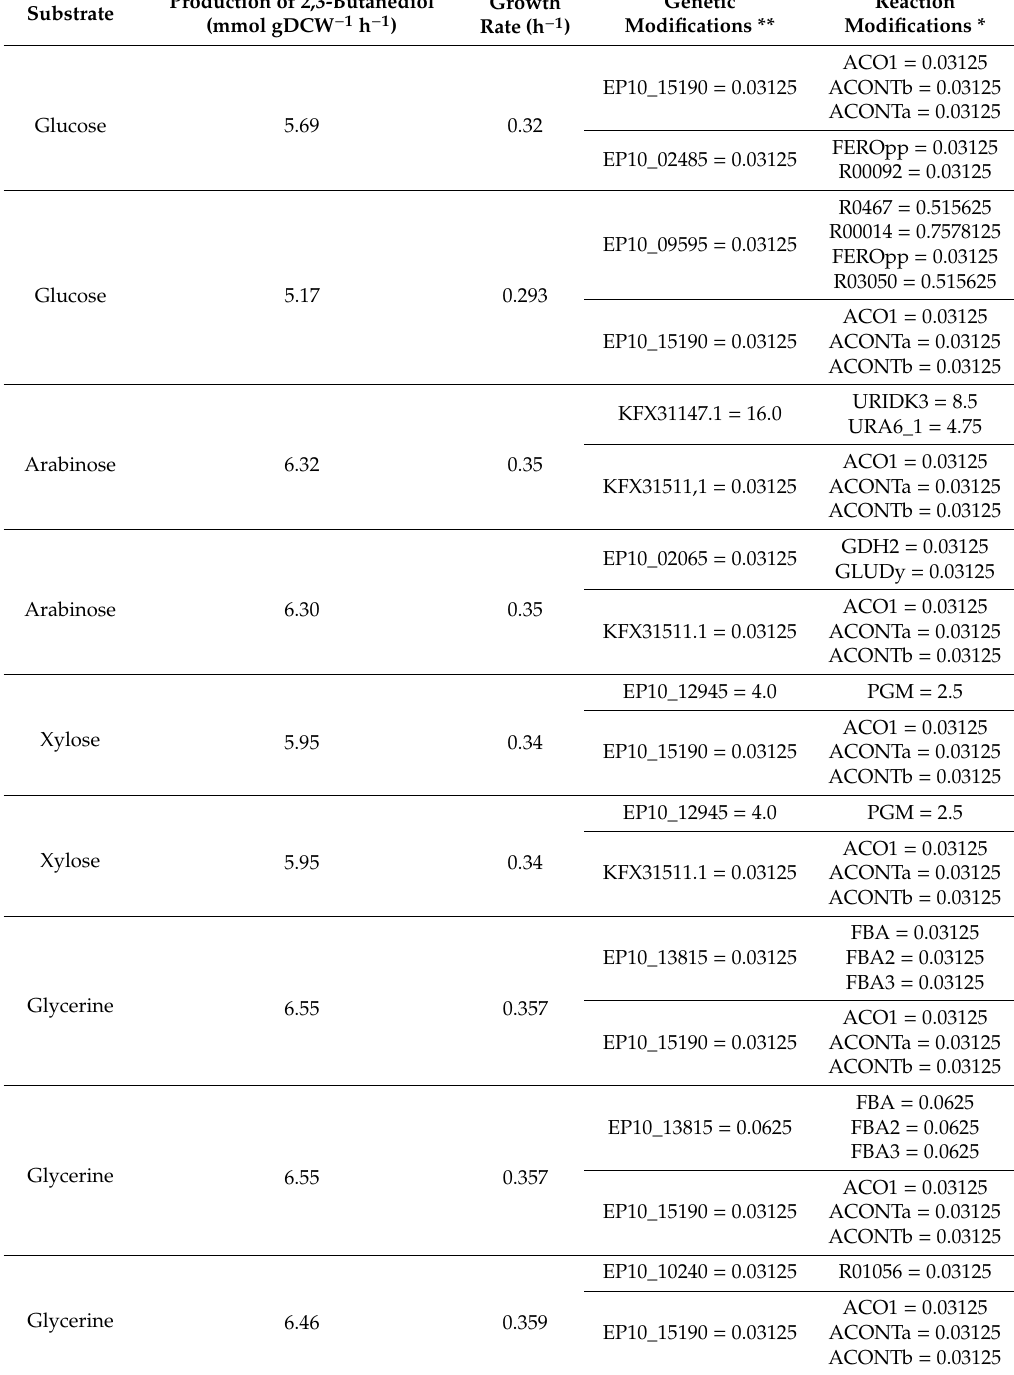
Table 4. Optimization results of iMK1321 model for 2,3-butanediol production with the MiMBL